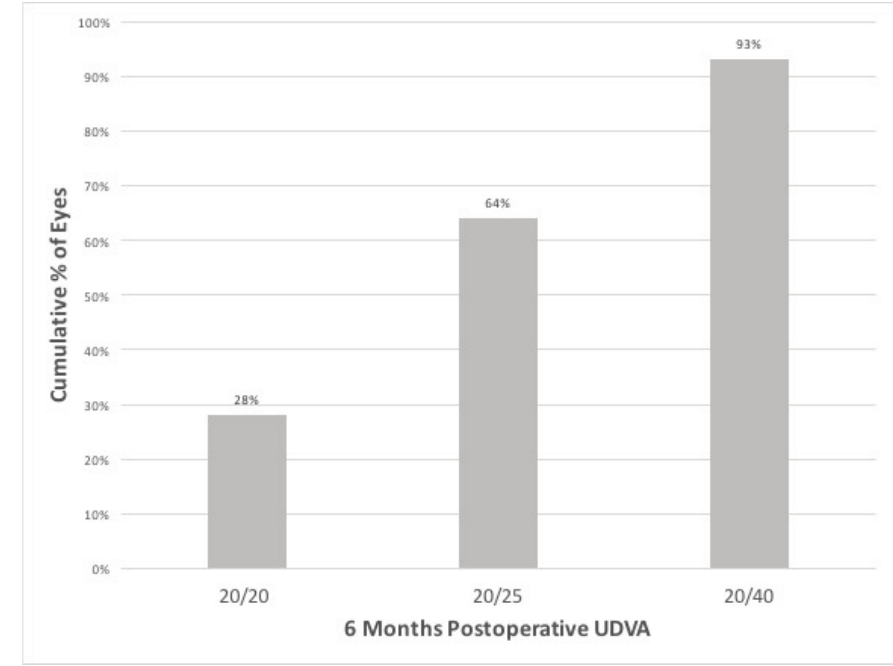
Figure 1. Postoperative uncorrected distance visual acuity (UDVA). Cumulative UDVA at six months